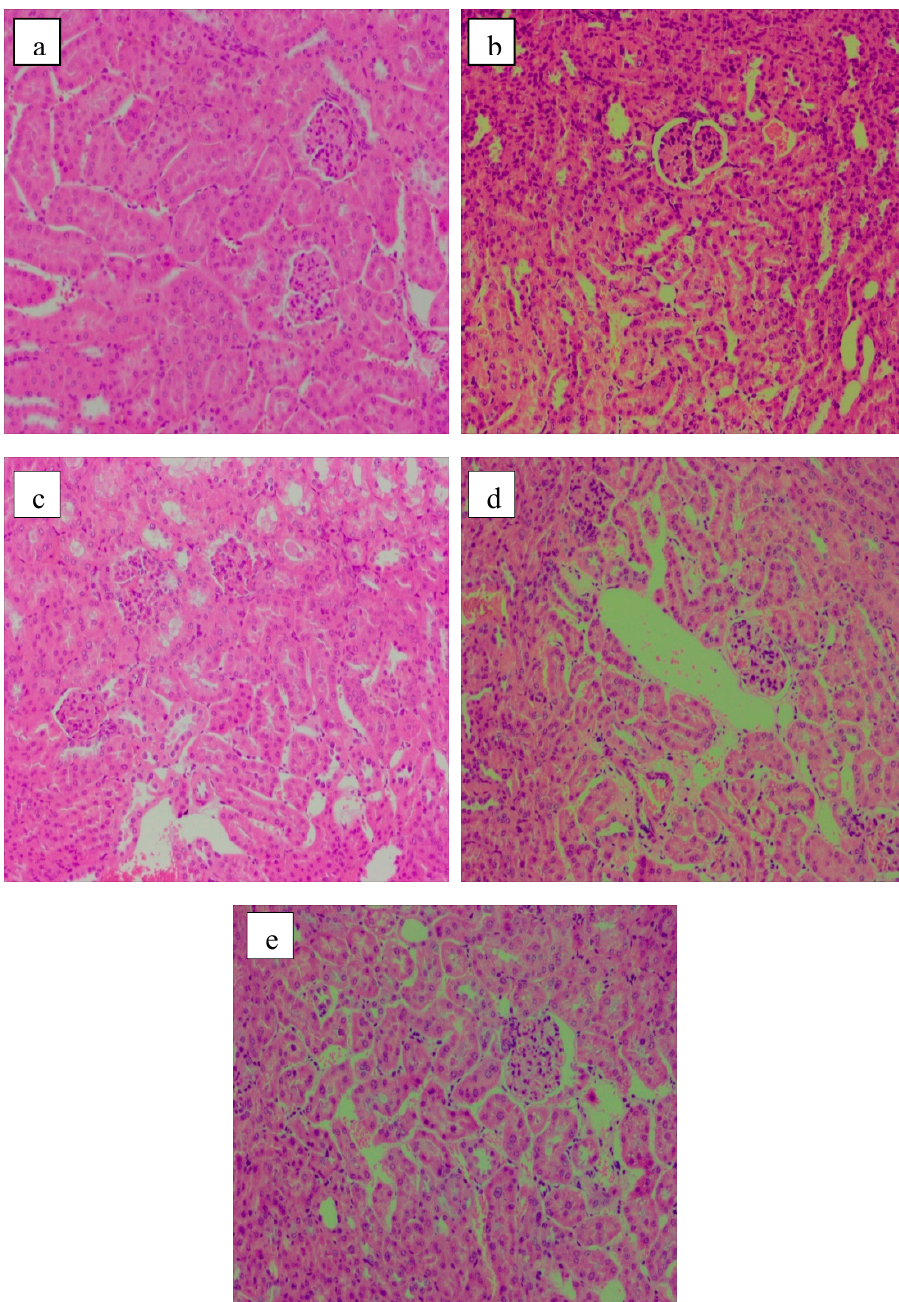
Figure 5. Kidney histology images (HE staining, 100×). ( a ) NG; ( b )MG; ( c )PG; ( d )LP; ( e )HP.